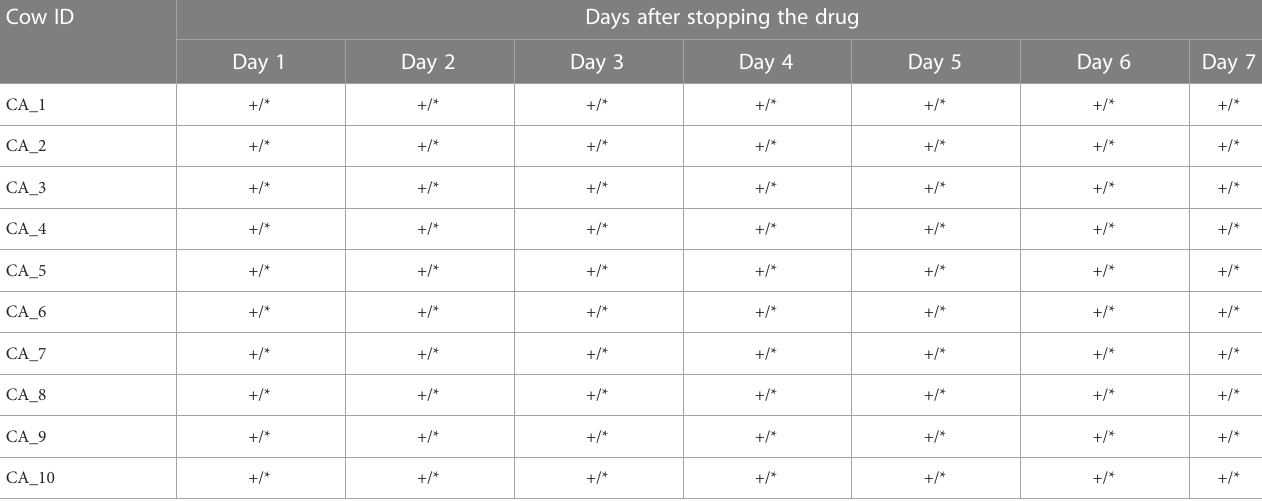
TABLE 1 Residue of cephalexin and kanamycin in milk of dairy cows after stopping to antibiotic. Cow